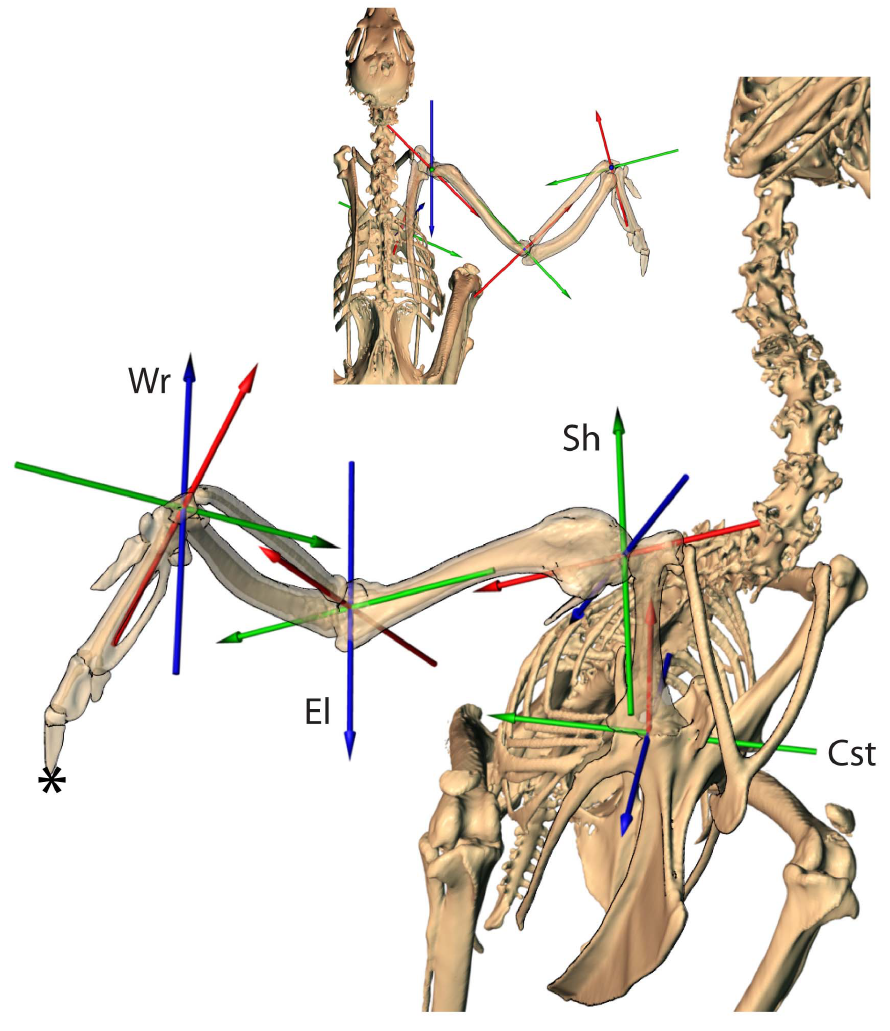
Figure 2. Joint coordinate system overview. Each joint is allowed 6 degrees of freedom (DOF) about an established coordinate system based on inertial axes of the downstream bone (e.g. humeral inertial axes determine glenohumeral axes). Joint rotations are ordered such that rotation about the blue axis moves the other two axes and bone model; rotation about green moves only the red axis and bone model; and rotation about the red axis only affects the bone model. Rotation order follows blue, green and red in each joint depicted. Cst=coracosternal joint: blue – abduction/ adduction; green – protraction/retraction; red – long axis rotation. Sh=shoulder (glenohumeral), El=elbow, and Wr=wrist joints: blue – elevation/ depression; green – protraction/retraction; red – pronation/supination. Note, none of the joints are depicted in their zero reference pose. For example, the elbow is extended 120 degrees from its zero position. Specifics for each joint are discussed in results. The * marks the distal-most point on the os phalanx distalis digiti used to determine upstroke and downstroke